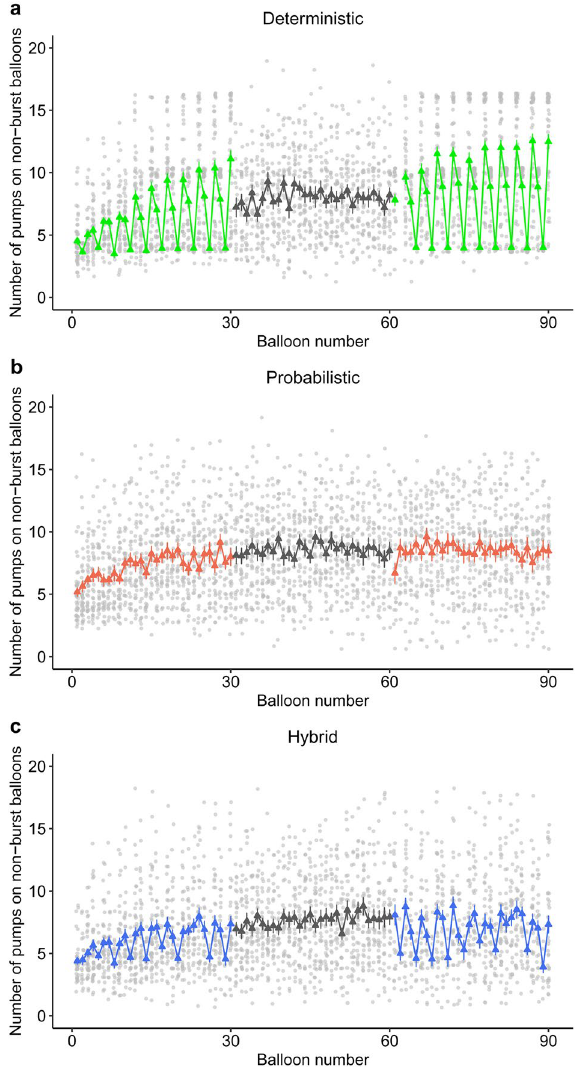
Figure 3. Sensitivity to the underlying regularities. The number of pumps on non-burst balloons are presented across all balloons of the task separately in each condition (deterministic, probabilistic, hybrid). Triangles denote the group (condition) mean of pumps on each balloon, light grey circles denote individual data points jittered to prevent overlap, and error bars denote standard error of mean in all figure parts. Each phase of the task encompasses 30 balloons (first phase: balloon numbers 1–30, random phase: balloon numbers 31–60, final phase: balloon numbers 61–90). Means and standard errors of the random phase are depicted in grey in all figure parts. Means and standard errors of the first and final manipulated phases are depicted in green (deterministic), coral (probabilistic), and blue (hybrid), respectively. Discontinuities in the lines connecting mean values indicate missing data for certain balloons in all figure parts (i.e., all participants of the given condition burst the particular